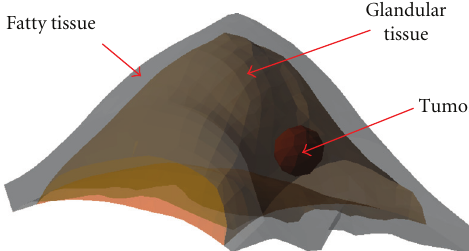
Figure 2: A 3D heterogeneous breast phantom extracted from real CT images, containing fatty tissue, glandular tissue, and a